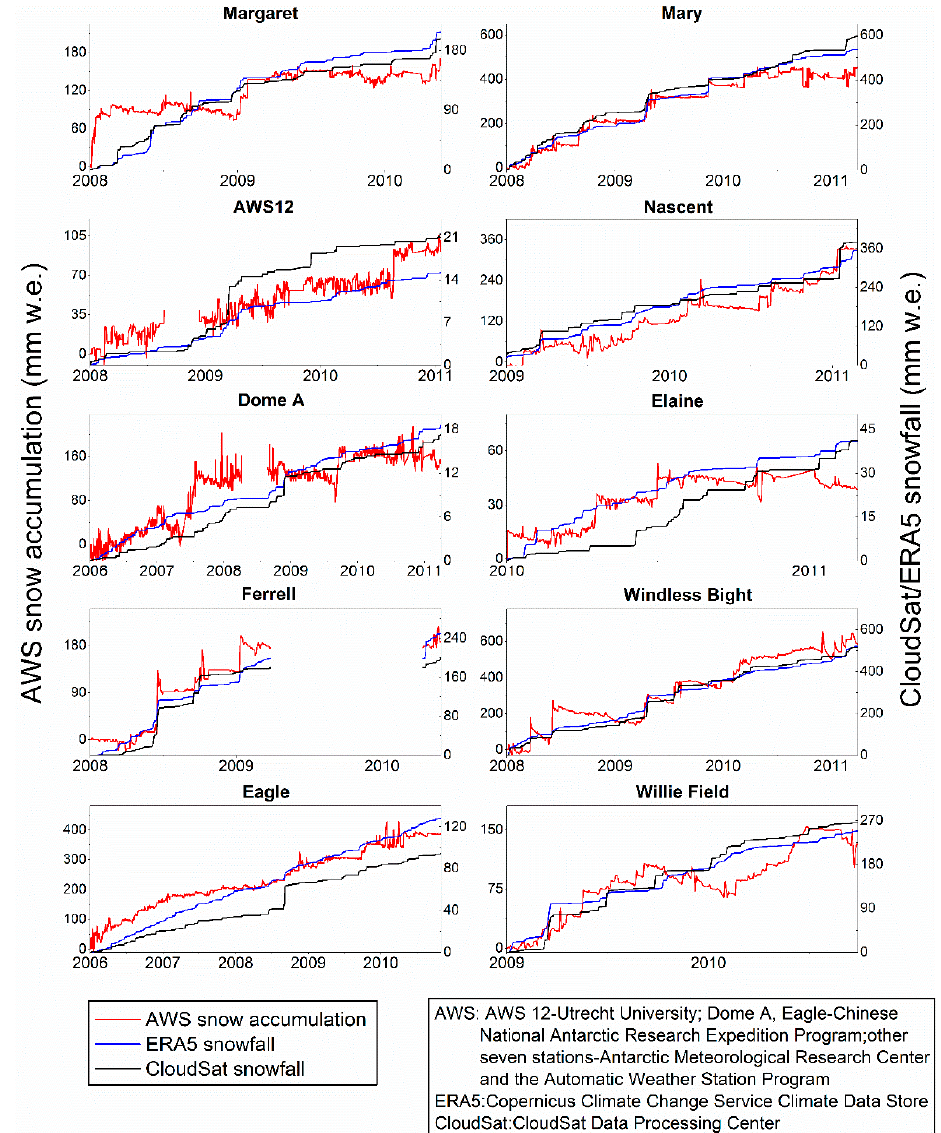
Figure 3. Cumulative daily AWS snow accumulation, CloudSat snowfall and ERA5 snowfall. The left-hand axes show AWS snow accumulation (mm water equivalent (w. e.)) and the right-hand axes show CloudSat snowfall (black) and ERA5 snowfall (blue) (mm w. e.). Table 2. Mean absolute error (MAE) (mm day –1 ) and root mean square error (RMSE) (mm day –1 ) of the magnitudes of daily CloudSat and ERA5 snowfall (and not the rates of change) for the ten AWS locations. Mean bias (MB) (mm year –1 ), percentage deviation (PD) and average CloudSat and ERA5 snowfall (SF-C and SF-E) (mm year –1 ) of the magnitudes of annual CloudSat and ERA5 snowfall for the ten AWS locations.